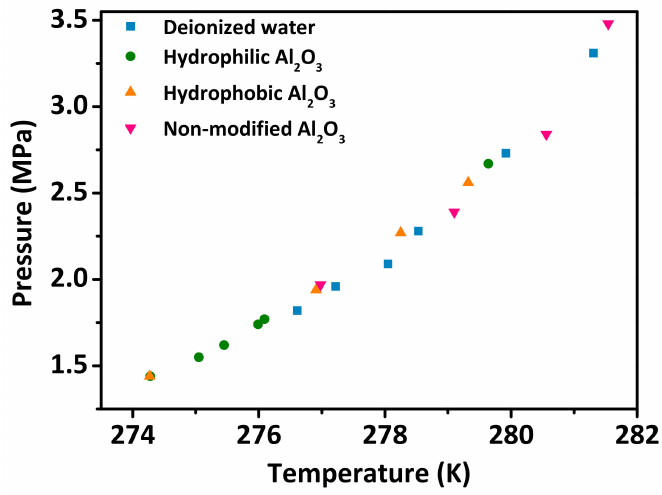
Figure 5. Phase equilibrium pressures and temperatures of the CO 2 hydrates in the presence of the Al 2 O 3